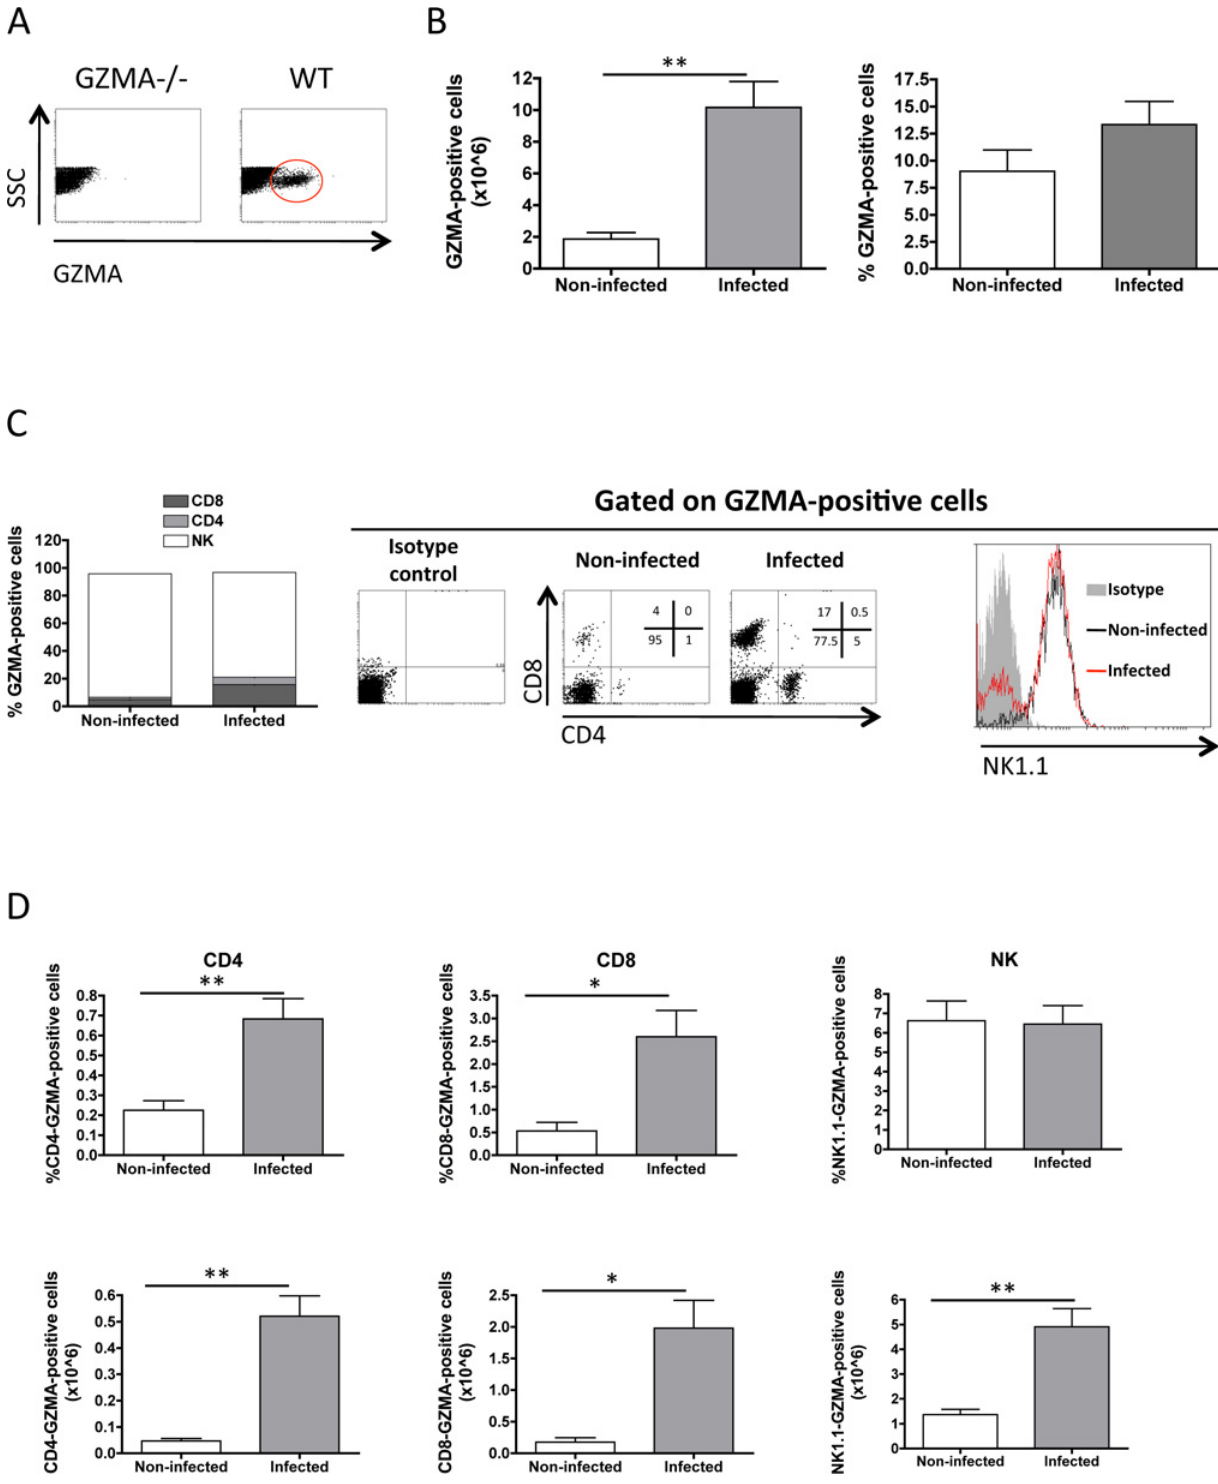
Fig 1. Granzyme A expression is increased in lungs after M . tuberculosis infection. A , lung cells from WT or GZMA-/- mice were intracellularly stained with anti-GZMA. A representative dot-plot showing GZMA staining is shown. GZMA-positive cells are contained in the red-circled region. B , C , D , Groups of five C57BL/6 wild-type mice were inoculated intranasally with a low-dose H37Rv challenge. Four weeks later, mice were sacrificed and GZMA expression analyzed in lung cellular populations. B , total GZMA-expressing cells. C , GZMA-expressing cell populations. Graph shows the relative proportions in